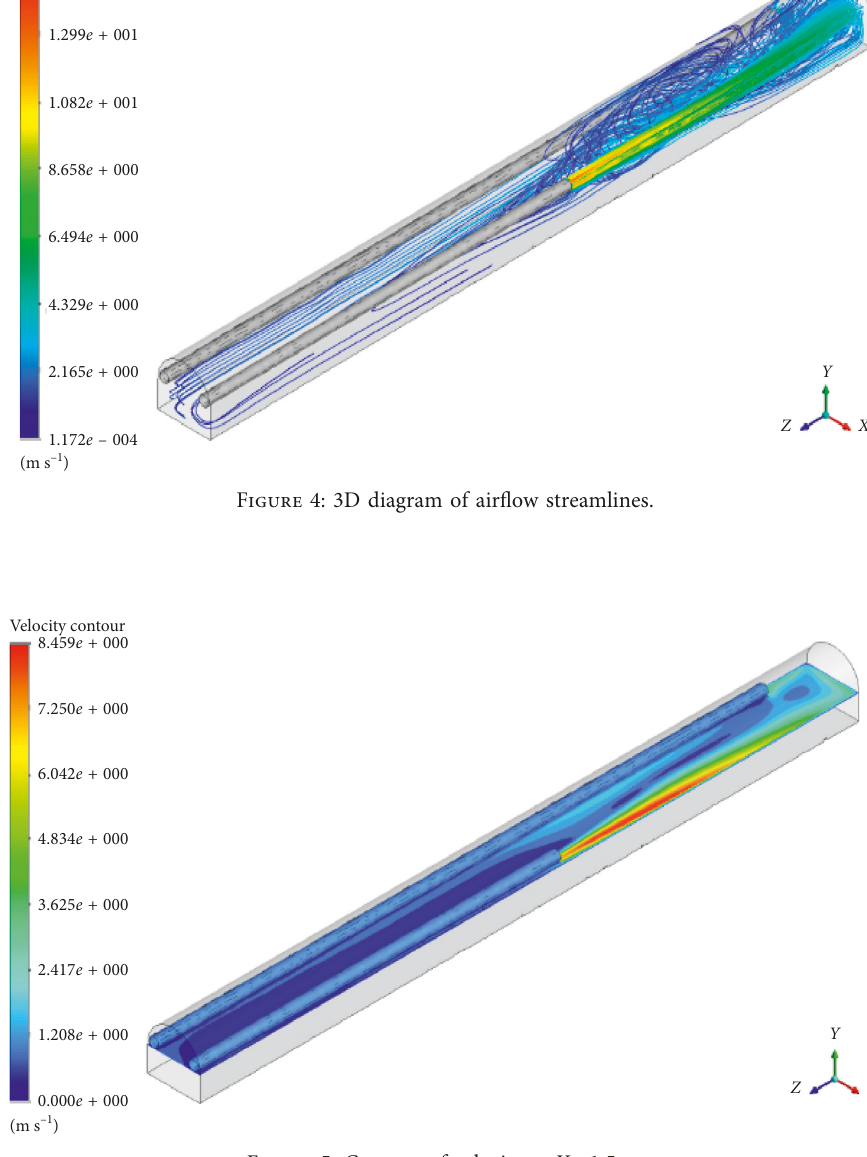
Figure 5: Contour of velocity at Y � 1.5m.